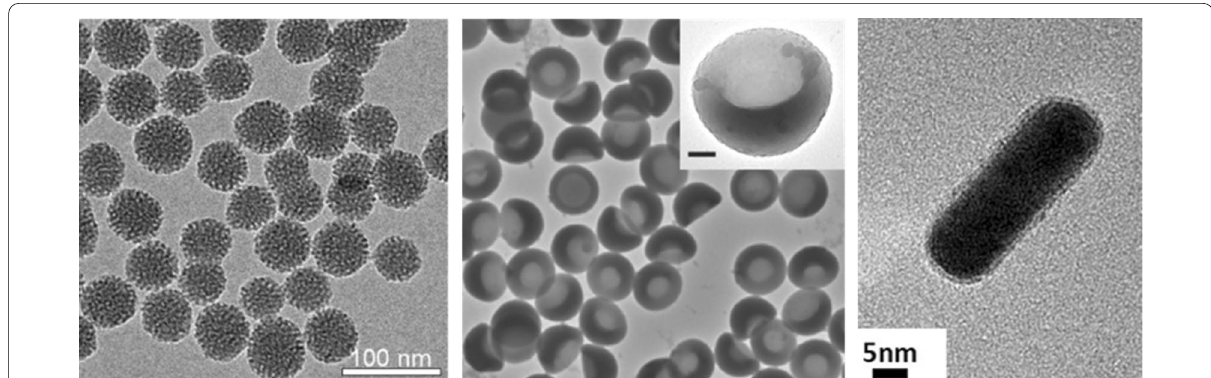
Fig. 3 TEM images of different GSNs. Pluronic F127 polymer coated hydrophobic MSNs (left), polymer nanocups (middle, scale bar is 100 nm), and peptide hydrogel coated gold nanorods (right). Adapted from references [37, 39, 84]. https:// pubs. acs. org/ doi/ 10. 1021/ acsom ega. 0c033 77, 2020, further permissions related to the material excerpted should be directed to the American Chemical Society. Copyright 2015, John Wiley and Sons, Copyright 2019, American Chemical Society,